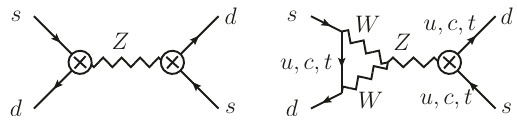
Figure 2 . Sample Feynman diagrams contributing to the off-diagonal field renormalization: A tt, ( se ) , tree-level Z (left panel), and A tt, ( se ) , one-loop Z (right panel). The circled cross denotes a coun- Q 00 Q 00 S 2 S 2 terterm